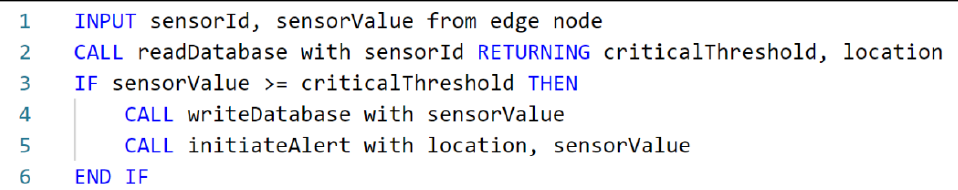
Figure 7. Algorithm for emergency detection.